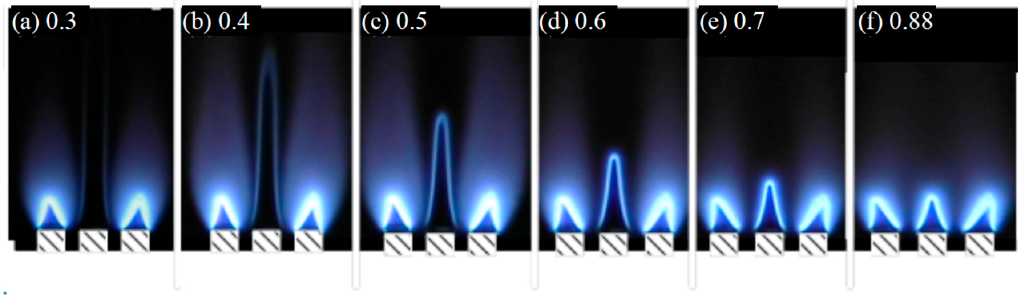
Figure 4. The flame chemiluminescence images of the outer flames for φ = 0.88 and the center flame varying from φ = 0.3 to 0.88 with equal spacing L = 2d and a constant even distribution exit velocity of 1 m/s.